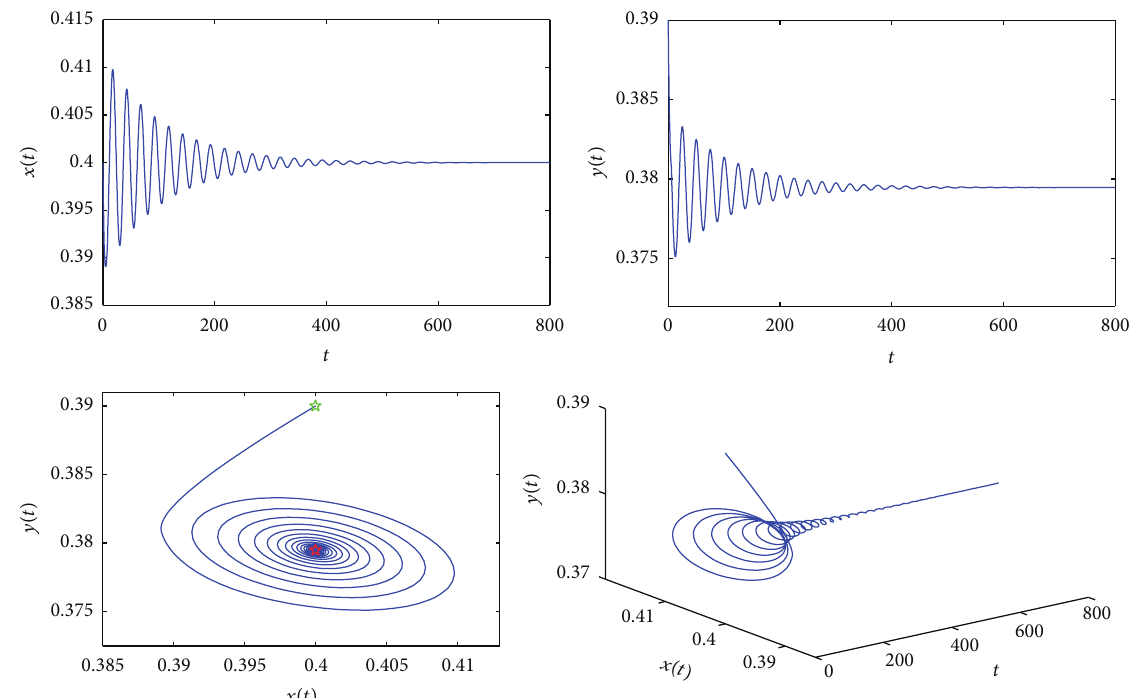
Figure 2: The trajectories and phase portrait of system (5). Initial values 𝑥 0 = 0.4 , 𝑦 0 = 0.39 . Parameters 𝑠 = 1 , 𝑐 = 0.6 . Delay value 𝜏 = 5.248 .